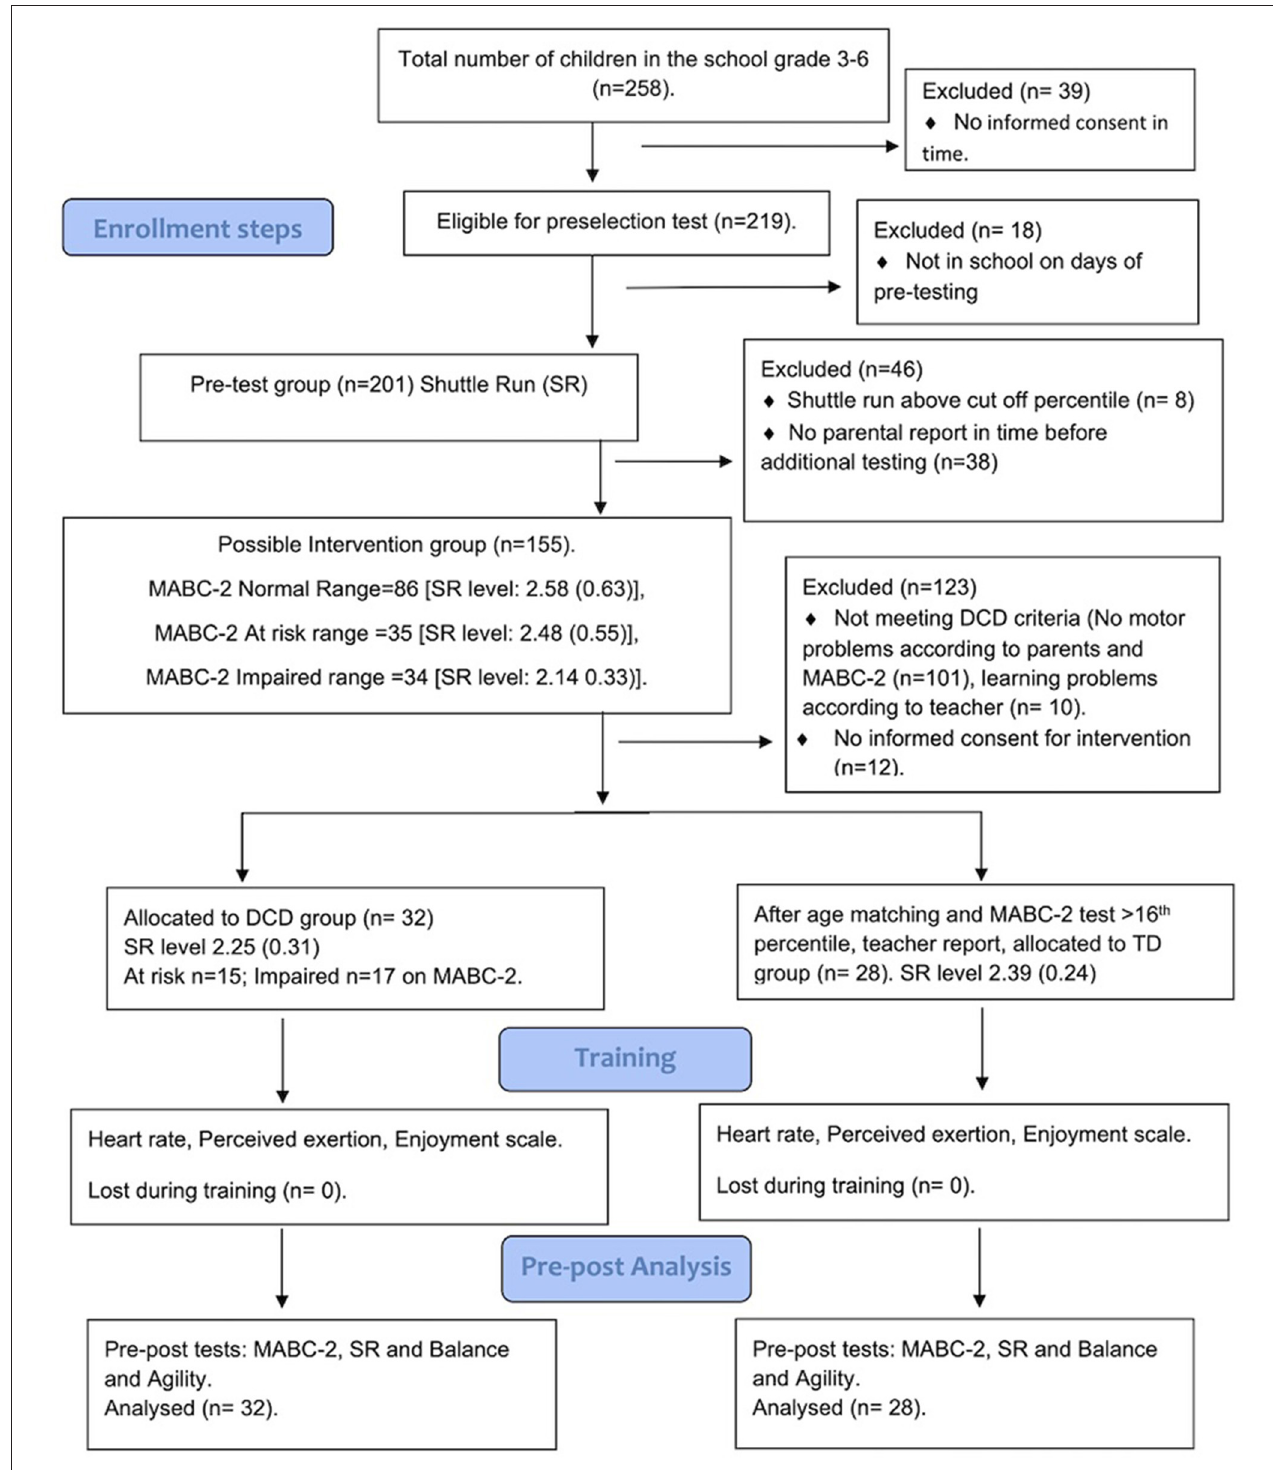
FIGURE 1 | Consort statement depicting the enrollment